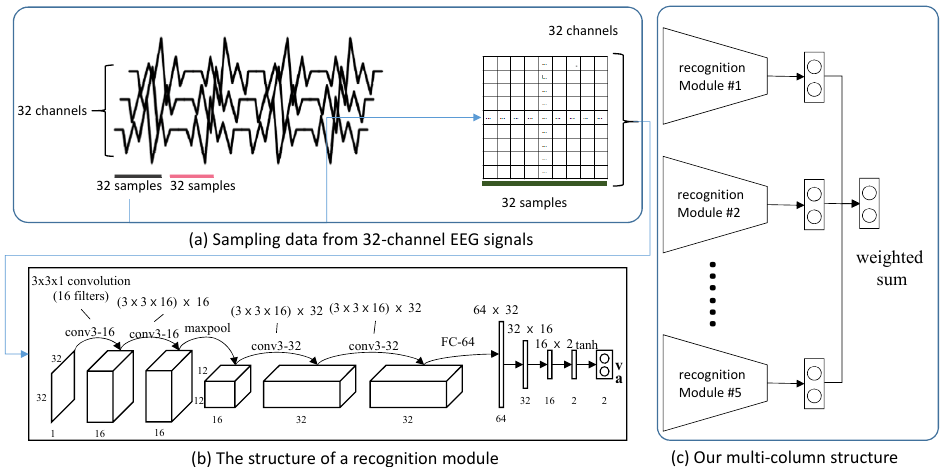
Figure 5. Structure and dataflow of our model, which is constructed according to